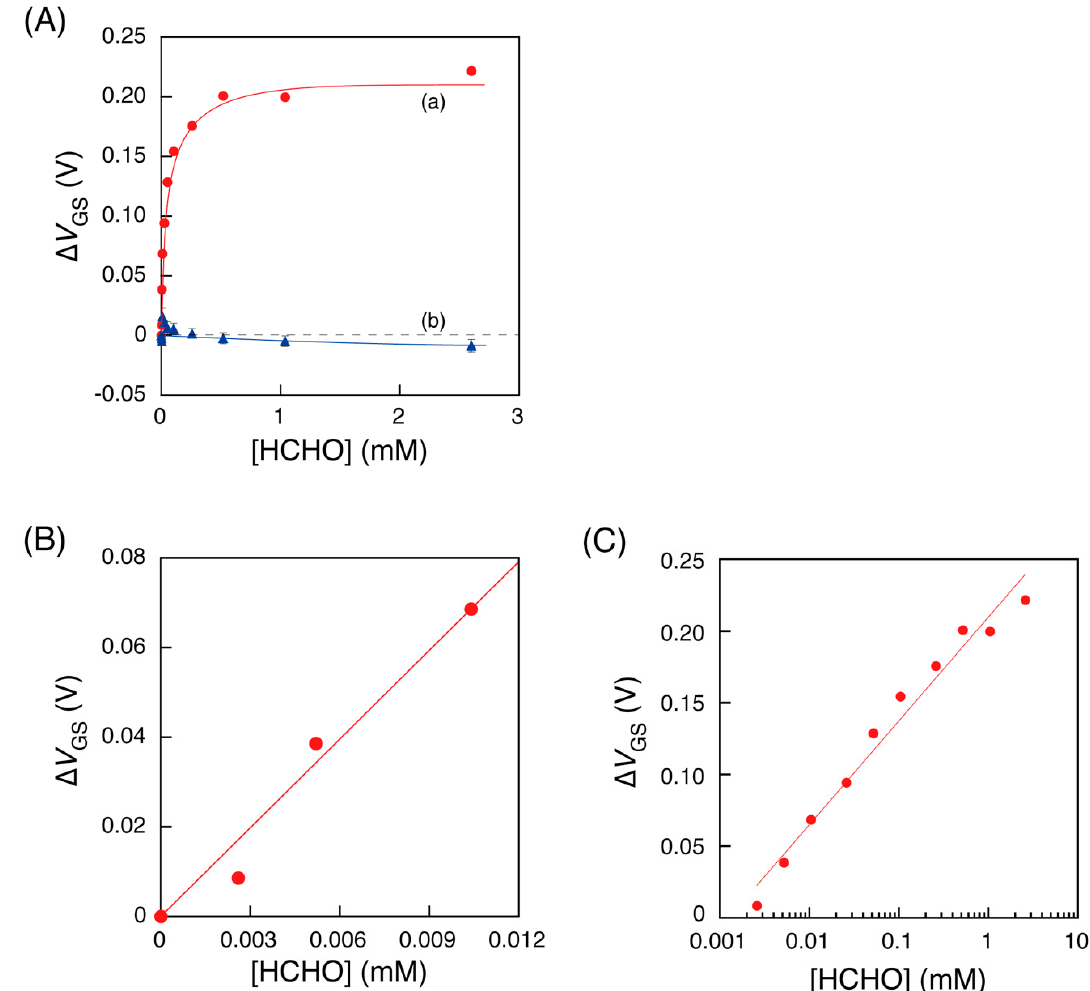
Figure 4. ( A ) Dependence of the gate voltage shifts ( ∆ V GS ) of transfer characteristic curves on the concentration of formaldehyde ([HCHO]); (a: circles) in the presence of NAD + and (b: triangles) in the absence of NAD + . ( B ) Linear approximation in the range of 0–10 µM formaldehyde. ( C ) Linear approximation to logarithm of the concentration of formaldehyde in the range of 0–2.6 mM. The maximum and average values of the SD for each plot were approximately ±7 mV and ±3 mV, respectively.